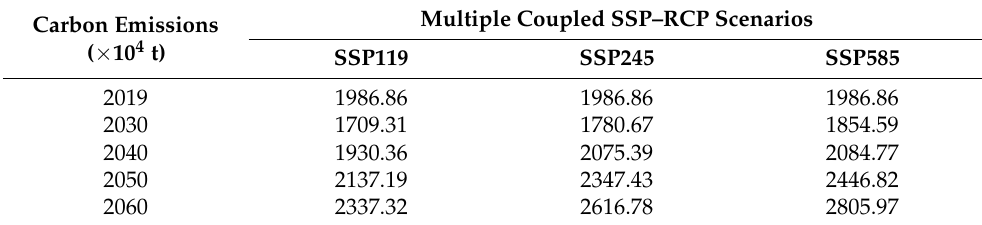
Table 4. Carbon emissions under future scenarios at different